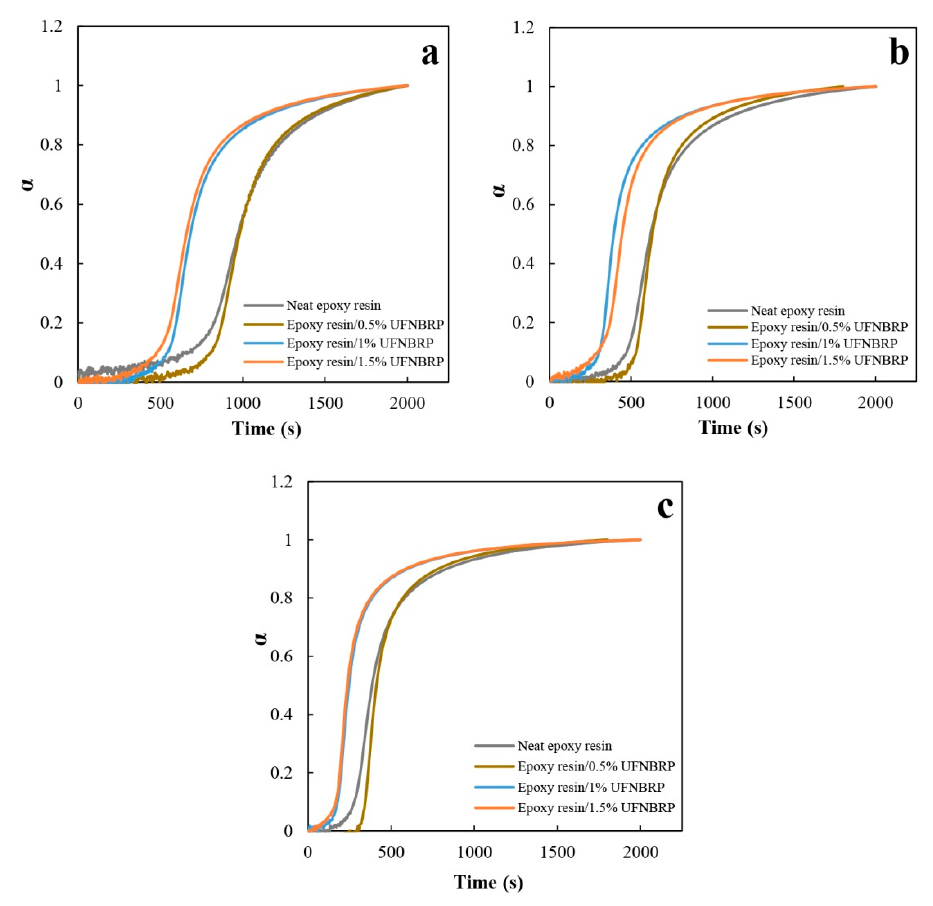
Figure 7. Degree of curing of epoxy resin and epoxy resin/UFNBRP nanocomposites at ( a ) 65 °C, Figure 7. Degreeofcuringofepoxyresinandepoxyresin/UFNBRPnanocompositesat( a ) 65 ◦ C, ( b ) 70 ◦ C ( b ) 70 °C and ( c ) 75 °C. and ( c ) 75 ◦ C. Table 3. Kinetics parameters of epoxy resins and epoxy resin/UFNBRP nanocomposites at tempera- tures of 65, 70 and 75 ◦